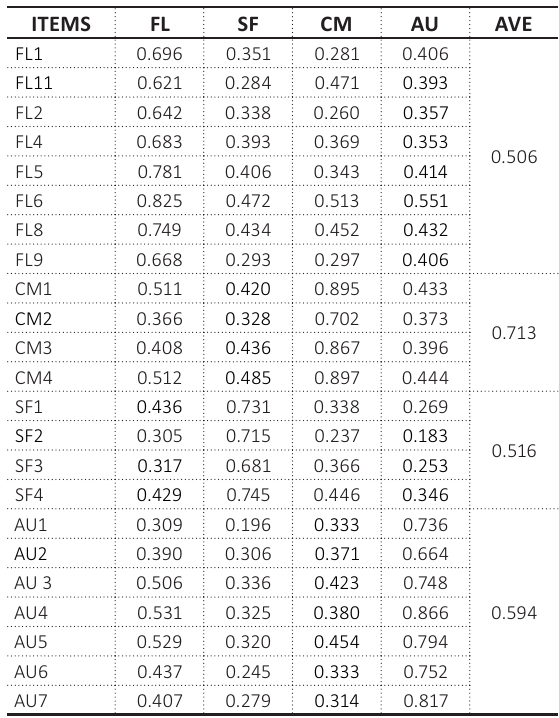
Table 2. Convergent validity results for extreme